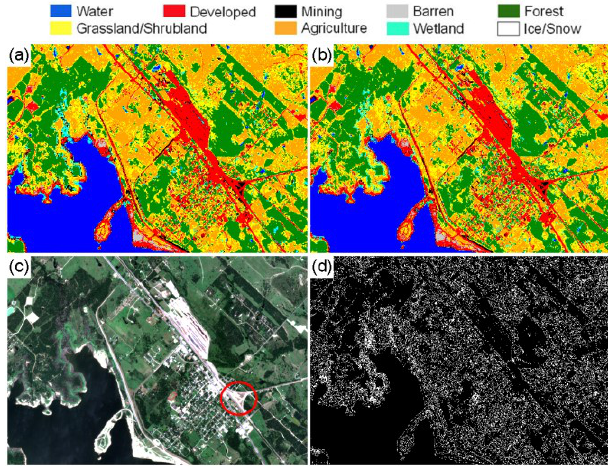
Figure 3. A subset area (5.7 km × 4 km) of the presented LCT’s region (Figure 2) for illustrating the classification results from different input variables. a) Map from Scenario 2. b) Map from Scenario 1. c) True colour composited image (Bands 4, 3, and 2). d) Difference between maps derived from Scenario 1 and 2.